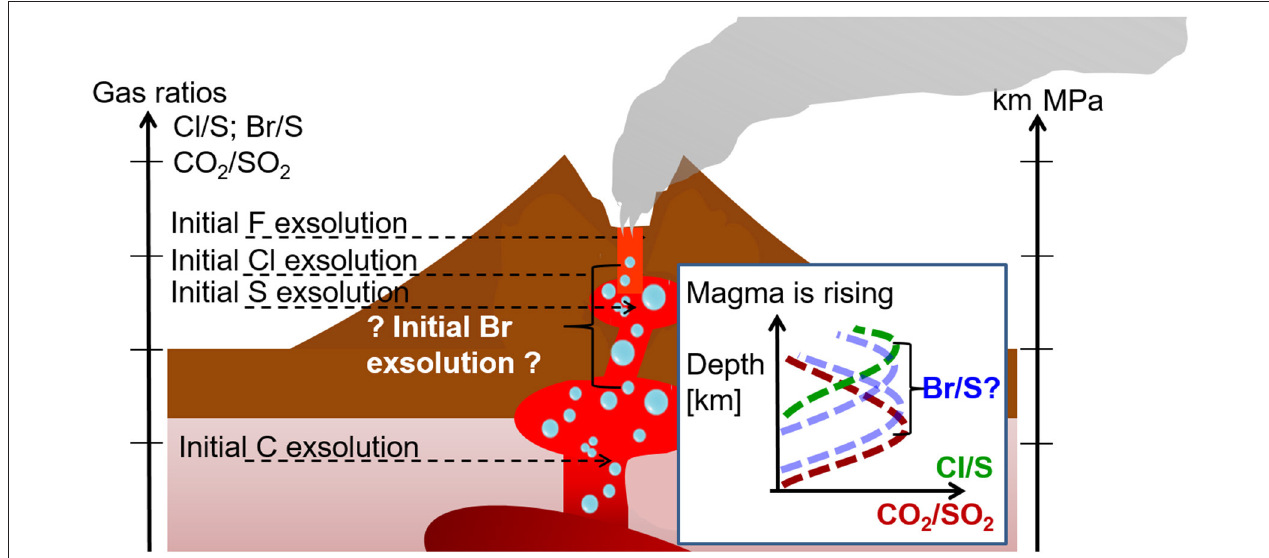
FIGURE 5 | Magma degassing model for volcanic gases. Carbon is held to exsolve at depth, S, Cl, F follow at lower pressures closer to the surface. Diagram illustrates changes of observed gas ratios if magma is rising. Whether bromine partitioning occurs at higher or lower pressure than sulfur is not clarified and part of current scientific discussions (for details see section Forecasting–Correlating Volcanic Plume Composition to Volcanic Activity).